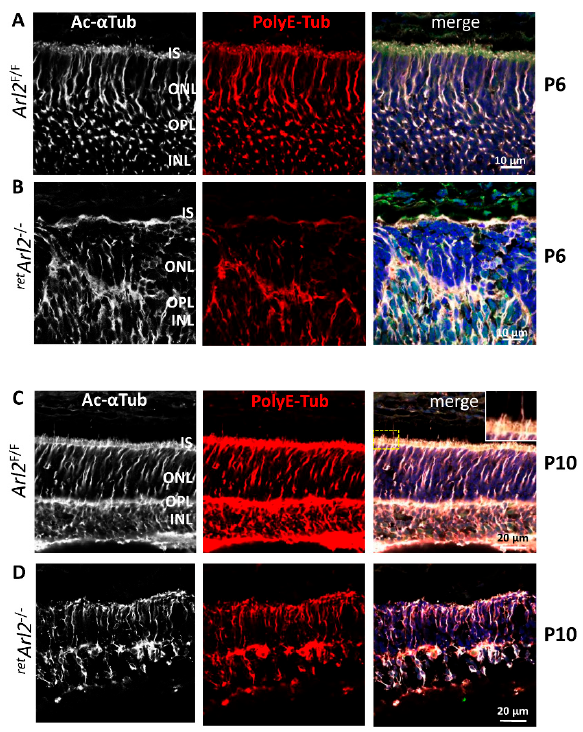
Figure 6. Immunohistochemistry of ret Arl2 − / − sections at P6 and P10. ( A – D ) ret Arl2 F/F (rows ( A , C )) and ret Arl2 − / − (rows ( B , D )) retina cryosections probed with anti-acetylated α -tubulin (Ac-Tub, white, left column), anti-polyglutamylated tubulin (PolyE-Tub, red, middle column). The right column shows merged images of Ac-Tub and PolyE-Tub contrasted with DAPI to show the ONL. Note severe distortions of the ONL at P6 (row ( B )) when ciliogenesis begins, but lesser distortions at P10 when OSs form (row ( D )). A dashed rectangle in ( C ) (right panel) indicates the area of enlargements shown in row ( C ) (upper right corner).